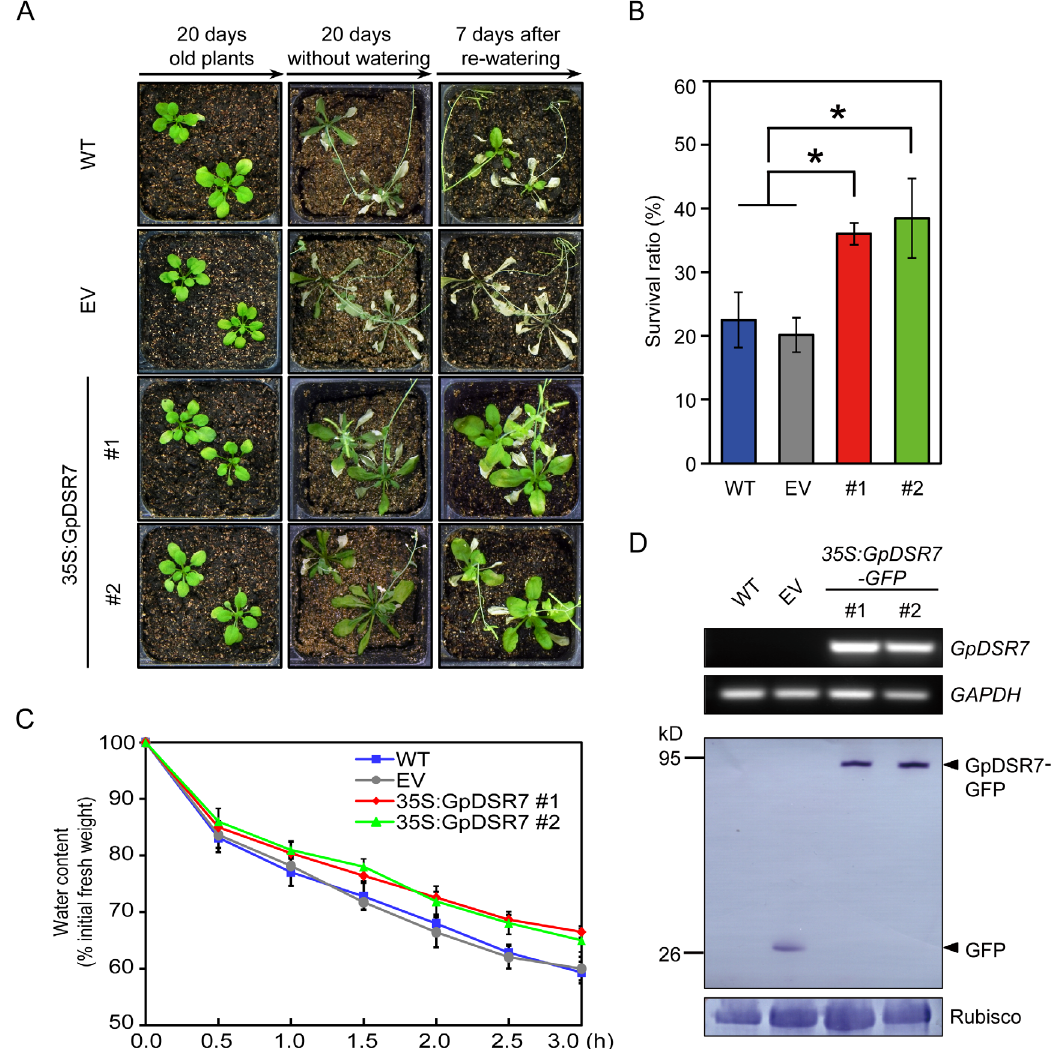
Fig 6. Drought response of 35S : GpDSR7 over-expressed transgenic Arabidospsis plants. (A) Seven-day-old seedlings were transferred to soil for a further 2 weeks of normal growth (left panel), subjected to progressive drought by withholding water for 20 days (middle panel), and then re-watered for 7 days (right panel). (B) Survival rate of plants after re-watering (n > 40). Asterisks indicate significant differences determined by Student ’ s t test ( * 0.01 < P < 0.05). (C) Leaves of 20-day-old plants were excised and weighed at various time points after detachment. Values are means ± SD of three individual plants. (D) Two independent T3 transgenic lines #1 and #2 were subjected to RT-PCR (upper) and immunoblotting (lower) for detecting the expression of GpDSR7. We have used the wildtype (WT) and the plants tranformed with empty vector (EV) as the control.